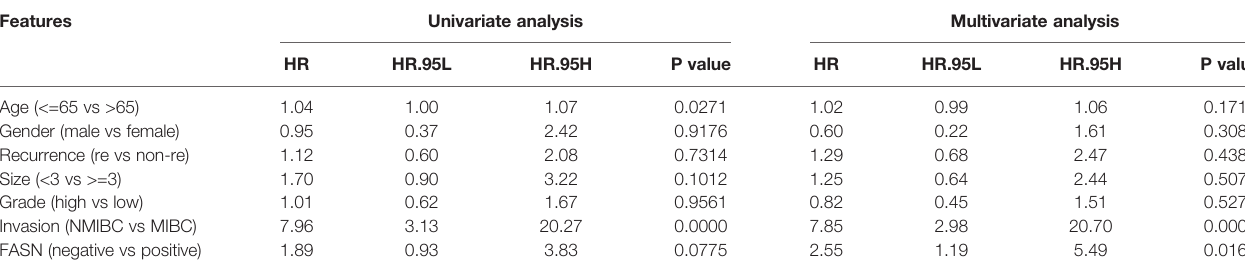
TABLE 1 | The results of univariate and multivariate COX regression analysis in BC patients in the CH cohort.